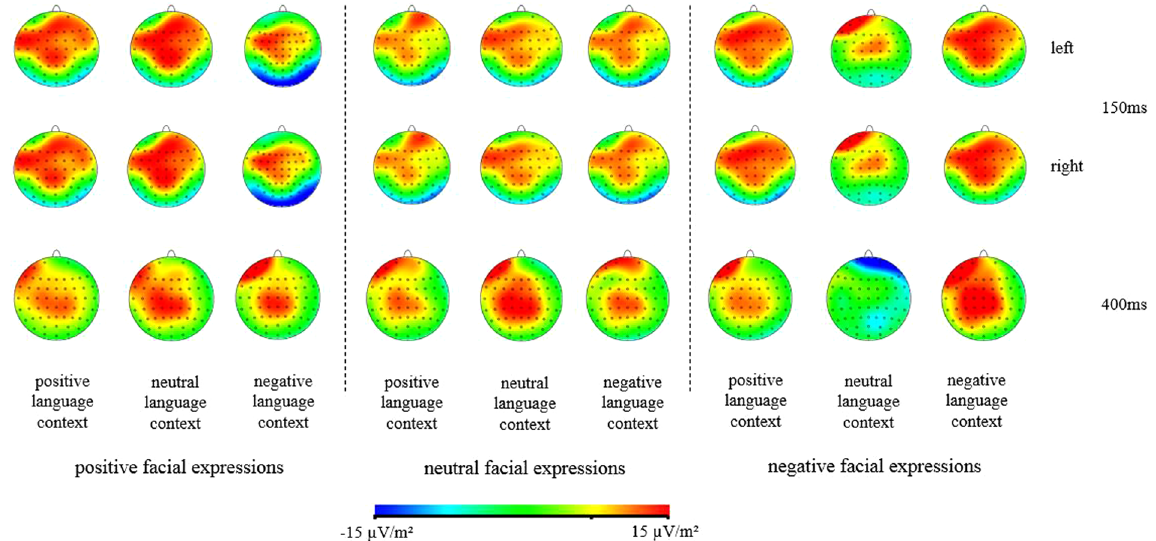
Figure 5. The 2D scalp topographic distribution of the LPP component elicited by positive, neutral, and negative facial expressions in different language contexts.